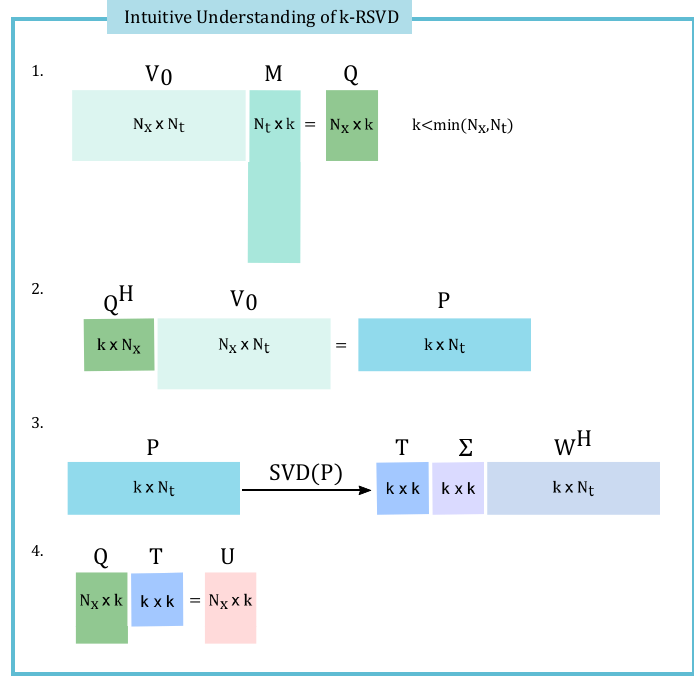
Figure 2. An intuitive understanding of k